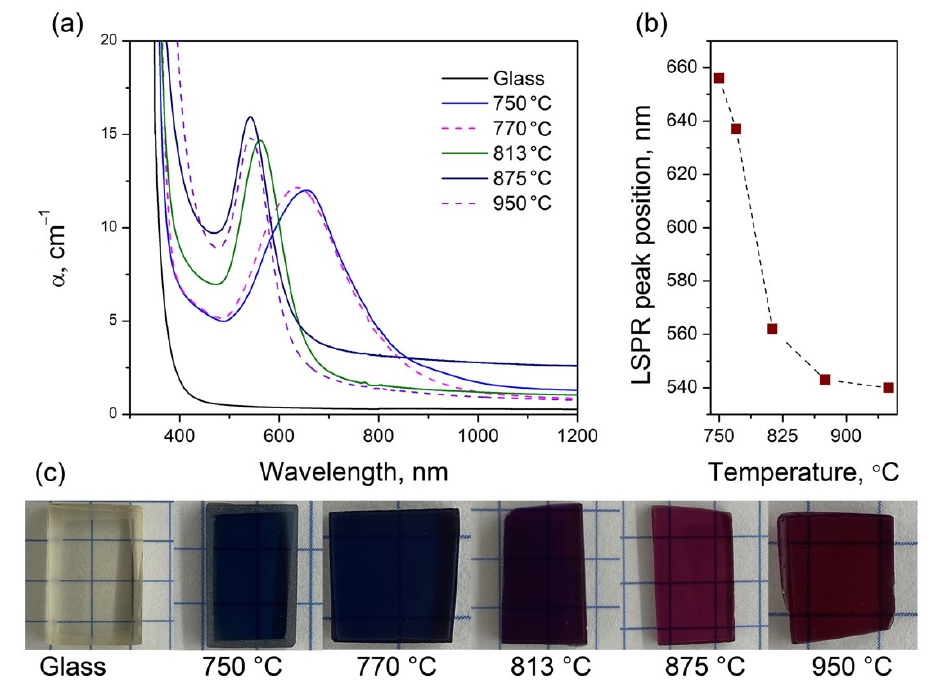
Figure 11. ( a ) Absorption spectra of the Au-doped glass samples before and after the heat treatment in the 650–950 °C range for 20 h; ( b ) change of the LSPR peak wavelength with a variation of the heat treatment temperature; ( c ) photos of the samples.